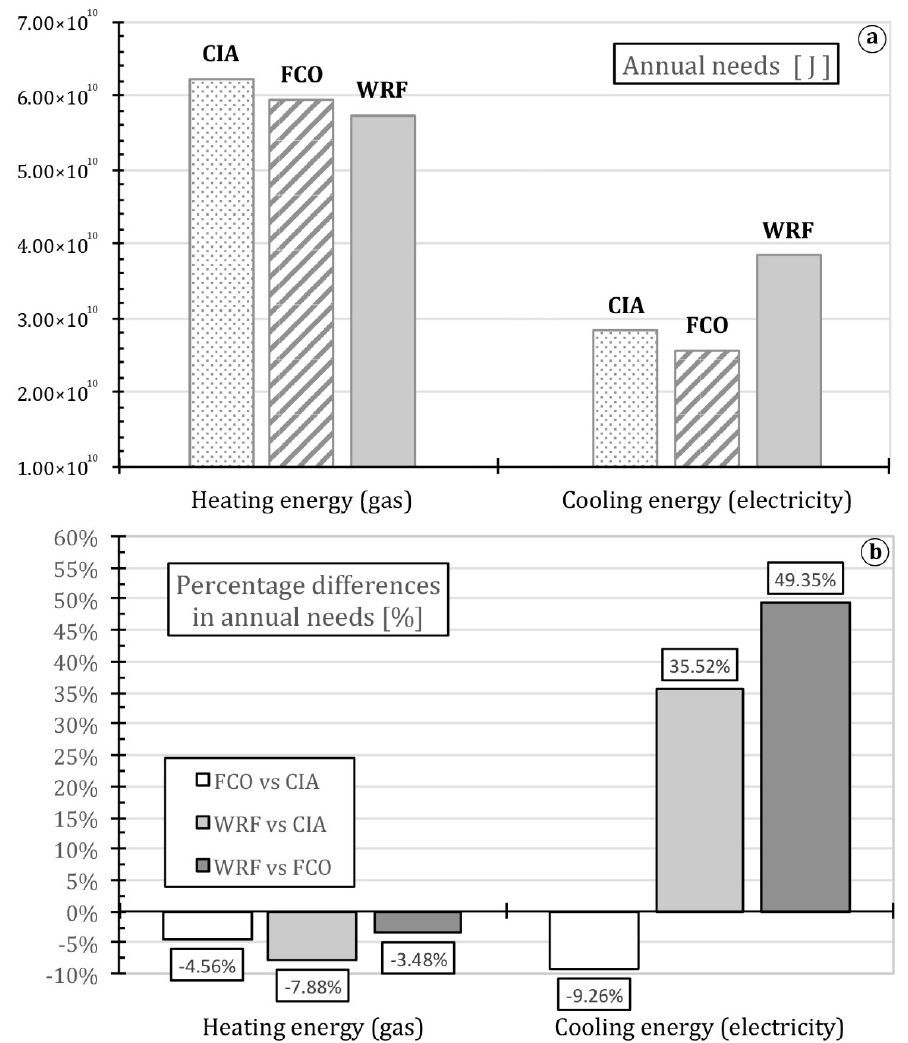
Figure 9. ( a ) Annual primary energy needs (J); and ( b ) percentage differences (%) in the energy consumption of (i) Fiumicino vs. Ciampino; (ii) WRF vs. Ciampino; and (iii) WRF vs. Fiumicino.